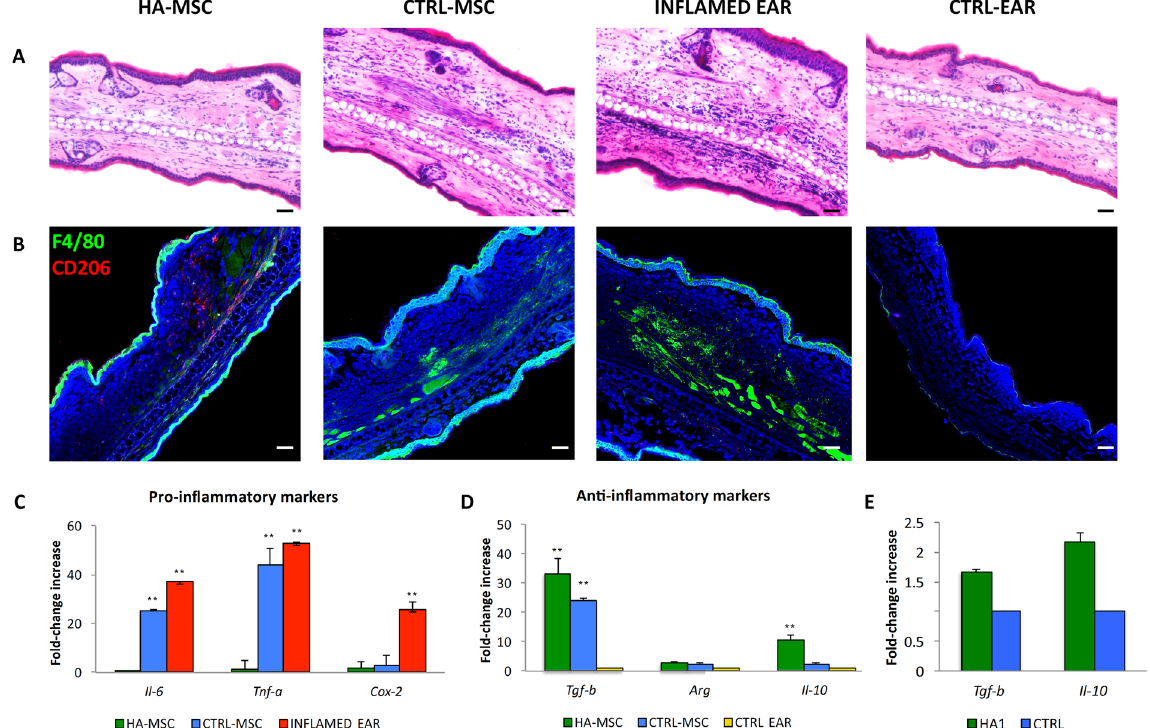
Figure 6. Reduction of inflammation following HA-treated MSC administration. Histological analysis of ear tissues (scale bars: 10 μ m) ( A ). The sections shows an alteration of tissue architecture in the inflamed ear and in the ones treated with MSC. Immunofluorescence analysis of ear sections at 72 hrs reveals that HA-MSC exhibited a significant reduction in macrophages infiltration compared with the other groups. Scale bars: 20 μ m ( B ). Moreover HA-MSC treatment enhanced the recruitment of anti-inflammatory macrophages (CD206 + ). Quantitative polymerase chain reaction for the expression of pro- ( Il-6, Tnf-a , and Cox-2 ) and anti- ( Tgf- β , Arg, Il-10 ) inflammatory genes ( C and D , respectively) on explants 72 hrs following the injection of MSC grown onto HA-coated TCP (HA-MSC) and untreated MSC (CTRL-MSC). The expression levels of pro-inflammatory molecules found in the inflamed ears (INFLAMED EAR) are also shown for control ear with no inflammation (CTRL EAR), used as baseline (n = 3; * p < 0.5, ** p < 0.01). Expression of Tgf- β and Il-10 mRNA levels in MSC treated with HA1 (n = 3), before cell injection compared to MSC grown in 2D conditions (CTRL) (E